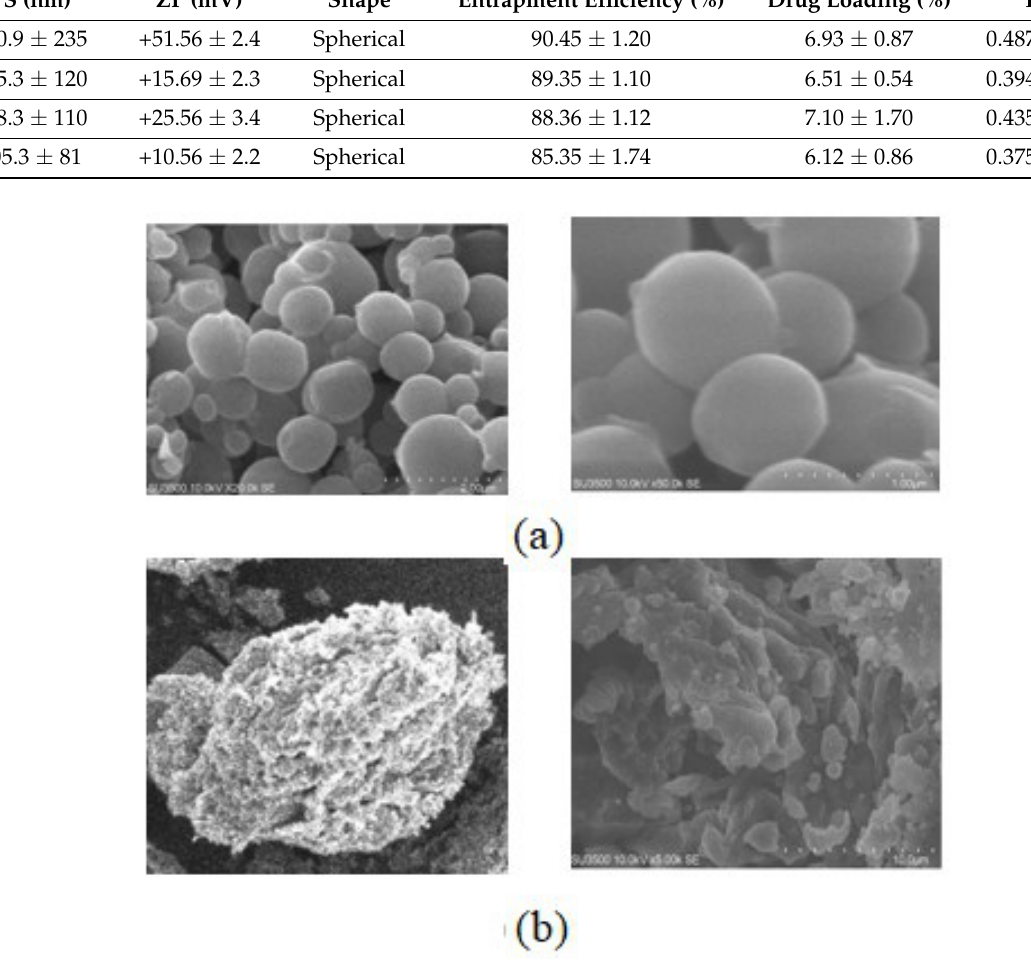
Figure 3. S EM images of ( a ) F1 (AMG – CS – HMW) and ( b ) F2 (AMG – CS –